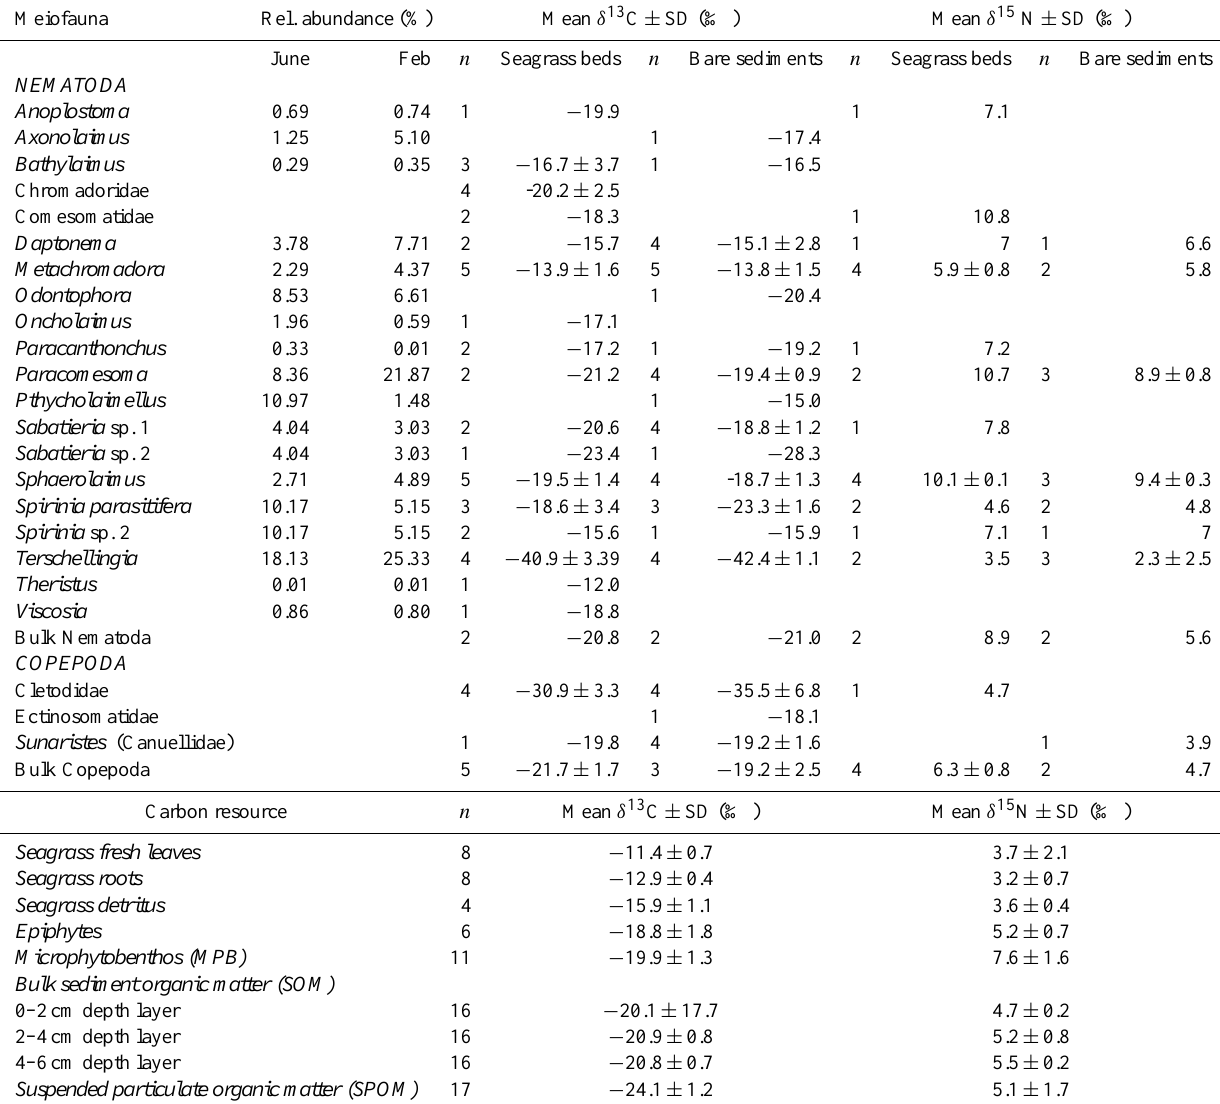
Table 1. Relative abundance (%) of nematode genera in Zostera noltii beds and stable isotope data of the potential carbon resources and meiofauna from the upper 2cm in seagrass beds and bare sediments ( n = number of replicate